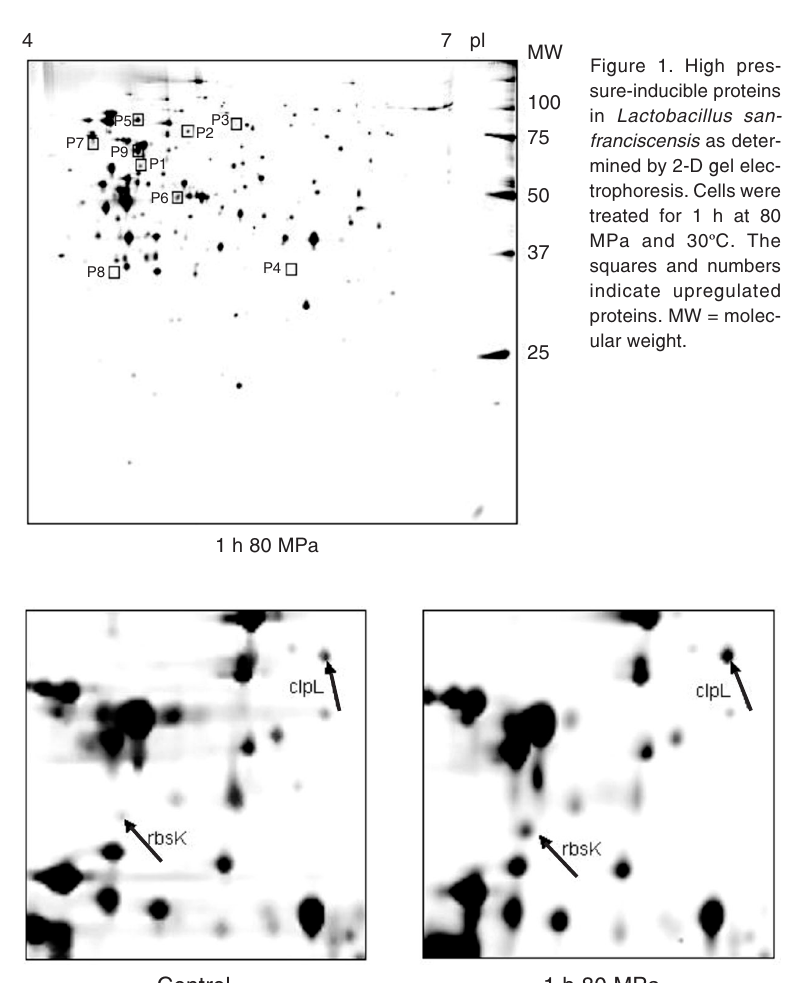
Control 1 h 80 MPa Figure 2. High pressure induction of rbsK/rbki and clpL. Cells were treated for 1 h at 80 MPa and 30 º C.